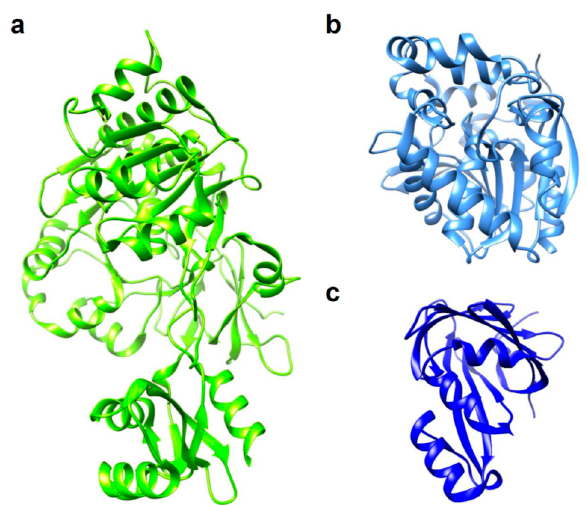
Figure 1. 3D structures of luciferases used in in vivo bioluminescence imaging (BLI). ( a ) Photinus pyralis firefly luciferase (FLuc); PDB ID: 5DVQ. ( b ) Renilla reniformis luciferase (RLuc); PDB ID: 2PSD. ( c ) NanoLuc luciferase (NLuc); PDB ID: 5IBO.